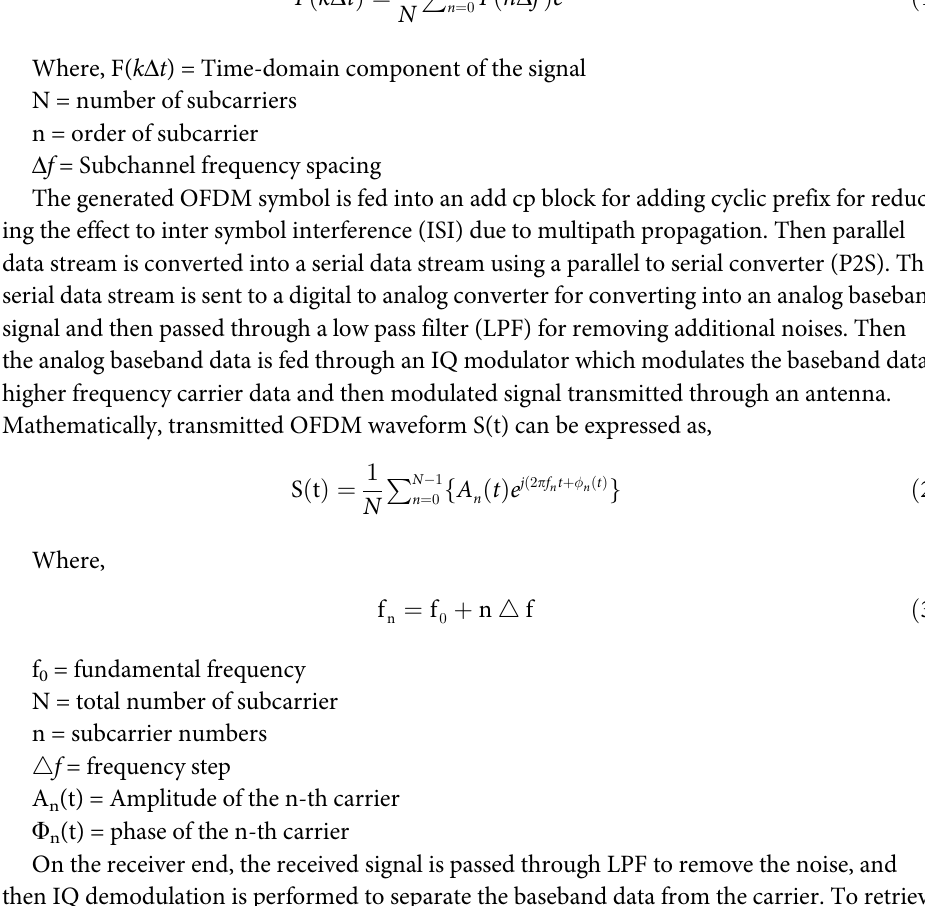
Keying (FSK), Phase Shift Keying (PSK), Quadrature Amplitude Modulation (QAM), Quadra- ture Phase Shift Keying (QPSK), etc. The modulated data is fed to an Inverse Fast Fourier